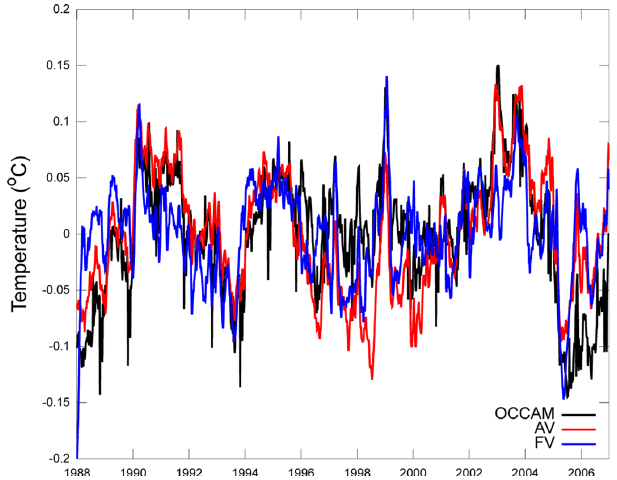
Fig. 5. Interannual detrended temperature variability in the OC- CAM model (black) and box model AV (red), FV (blue), all de- trended and with the mean removed. The AV box model is run as described in Sect. 2.2, while the FV box model is run with data taken from OCCAM for F ∗ , using this to infer the F ∗ , but 26 ◦ N 36 ◦ N otherwise as described in Sect. 2.3. We obtain the deseasoned com- ponents by removing the seasonally varying climatology. The AV box model deseasoned OHC StD of the deviation from the OCCAM model is 0.041 and 0.048 ◦ C for the FV box model, while the StD of the deseasoned OCCAM model is 0.056 ◦ C. This confirms that Fig. 6. Validating the assumptions for F ∗ of the FV box model. 36 ◦ N the box model can be used to investigate the full and deseasoned Panel (a) shows the full signal, while panel (b) shows the desea- components of the oceanic and air–sea causes of OHC variability. soned component. In both panels, the blue line is the FV box model is de- as in Fig. 4. The black line shows the case where F ∗ 36 ◦ N rived from the OCCAM model. The grey line shows a case where = 0. The dark grey stippled line shows the model using in- F ∗ 36 ◦ N ferred forcing at 36 ◦ N obtained using only the low-frequency com- ponent of F ∗ . The high-frequency component was included in 26 ◦ N the FV box model using the RAPID-based data as F ∗ to infer 26 ◦ N F ∗ 36 ◦ N